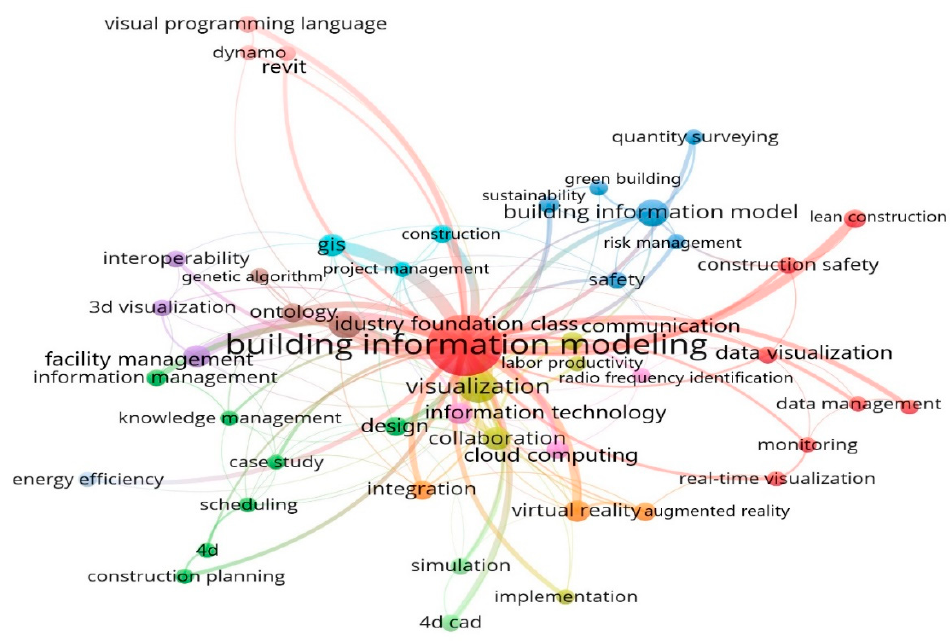
Figure 6. Network of co-occurring keywords.